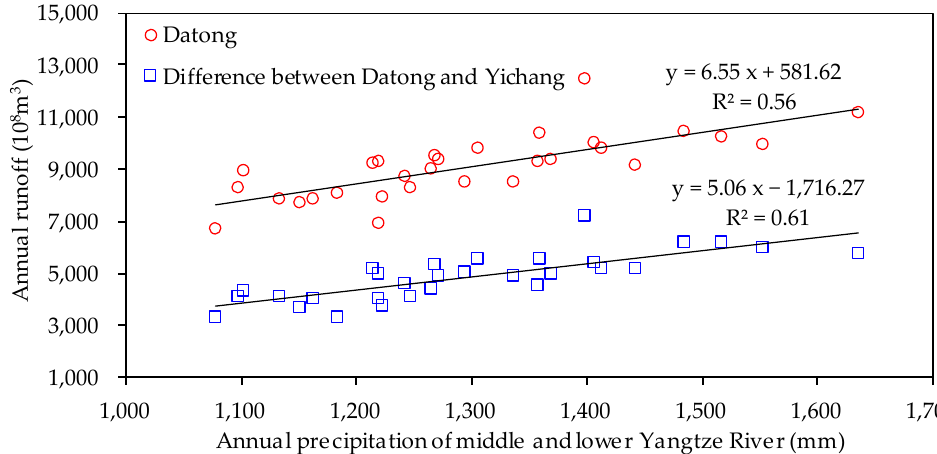
Figure 4. Relationship between the precipitation and runoff since 1990.